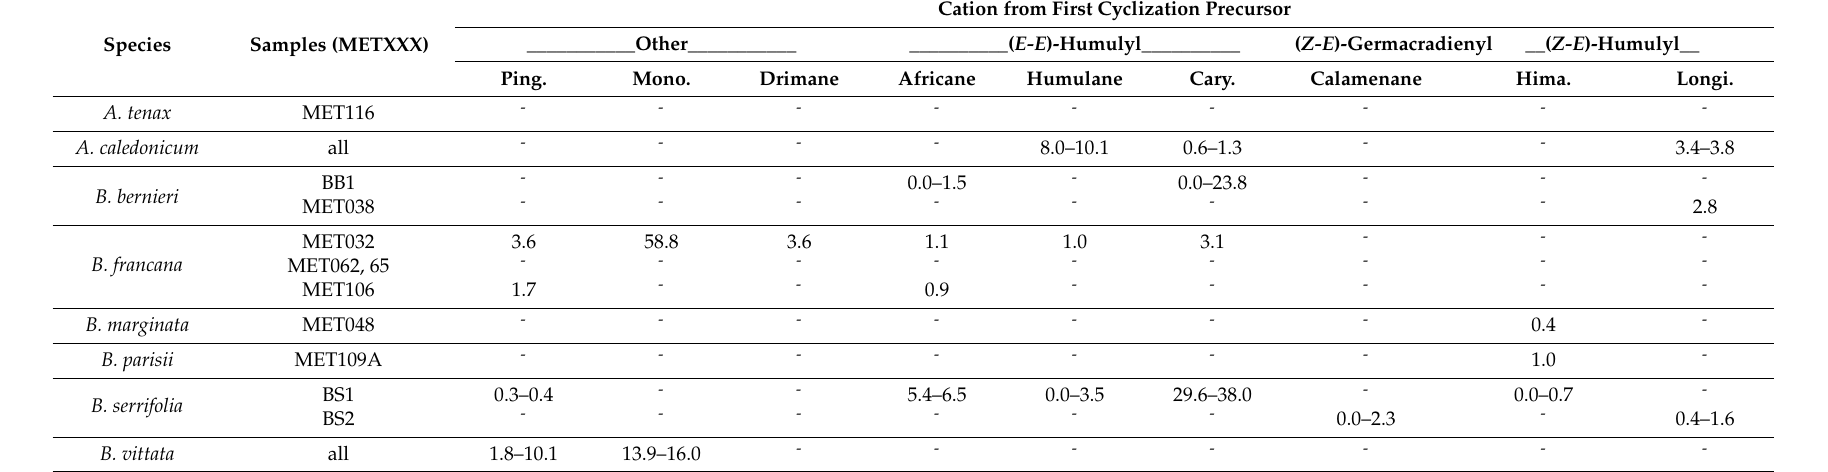
Table 6. Distribution of detected pinguisane-, monocyclofarnesane-, drimane-type sesquiterpenes and sesquiterpene types belonging with the ( Z-E )-humulyl cation, ( E-E )-humulyl cation and ( Z-E )-germacradienyl cation precursors (relative percentage,